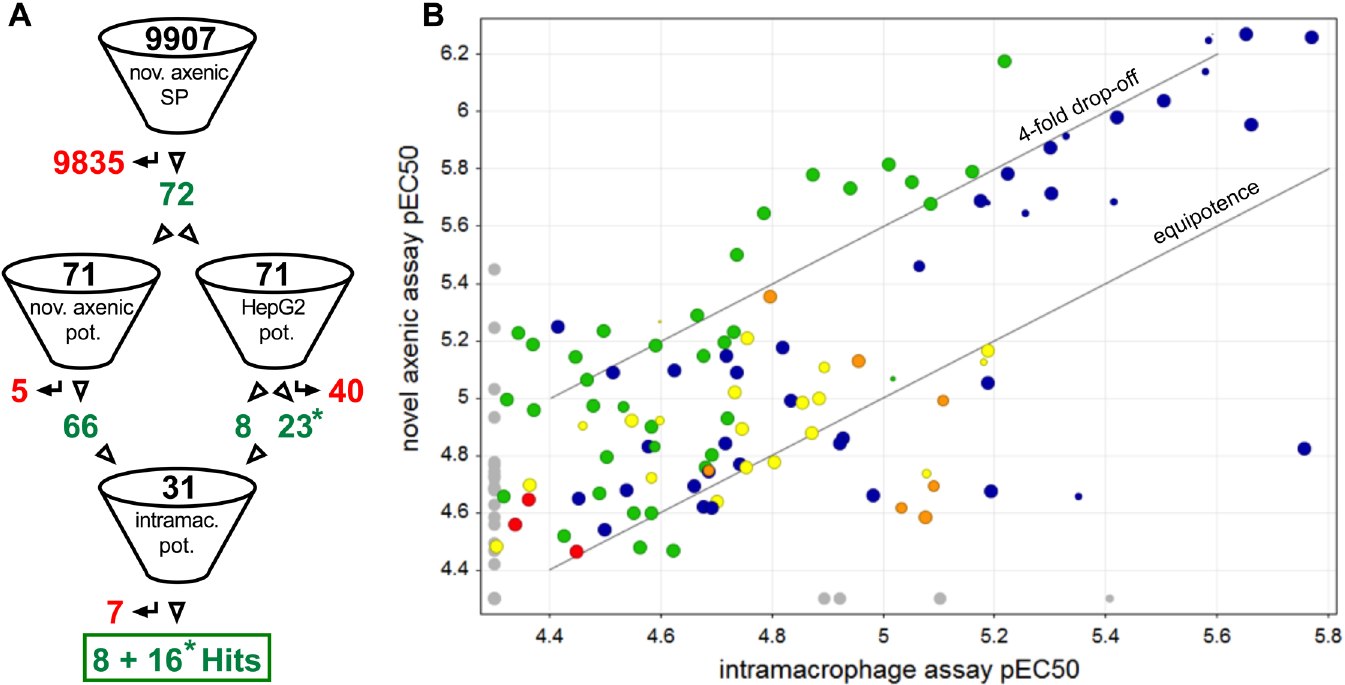
Fig 5. Screening cascade for DOS screen (A) and potency comparison of hits from the DOS library between the novel axenic and intramacrophage assay (B). A: Screening cascade. Numbers of compounds that passed and failed the hit selection criteria are shown respectively in green and red. Numbers marked with an asterisk indicate that the selectivity window is unknown and may be (cid:1) 10 (no effect seen in HepG2 assay, activity in the cidal axenic assay pEC50 < 5.3). The cascade starts with screening 9,907 compounds in the novel axenic assay at a single concentration (nov. axenic SP). Identified hits are processed in potency format in both the novel axenic assay (axenic pot., for activity confirmation) and HepG2 assay (HepG2 pot., toxicity information against the human cell line HepG2). Active compounds that provide a (cid:1) 10-fold toxicity window are processed in the intramacrophage potency assay (intramac. pot.) for hit confirmation, resulting in 24 hits. B: Comparison of novel axenic and intramacrophage mean pEC 50 values for 141 compounds. The size of the markers is inversely related to the toxicity against the THP-1 cells (i.e. high toxicity – small symbol). Colour is by series (green: Ortho Azetidine Nitrile, blue: Azetidine Nitrile, orange: Povarov, red: SnAr 8-ortho, yellow: other). Data set represents three biological replicates for the novel axenic assay (with the exception of one compound with two replicates only) and at least two replicates for the intramacrophage assay.